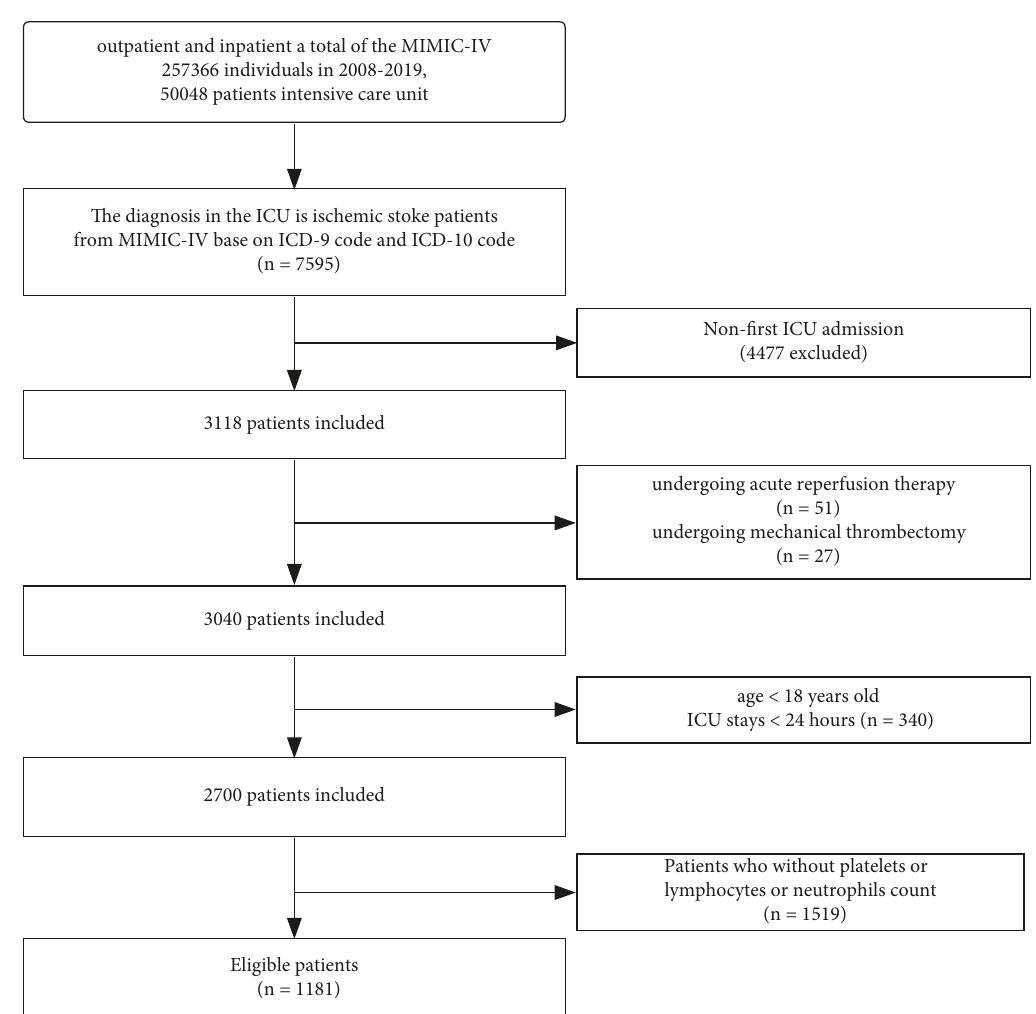
Figure 1: Flowchart of subject